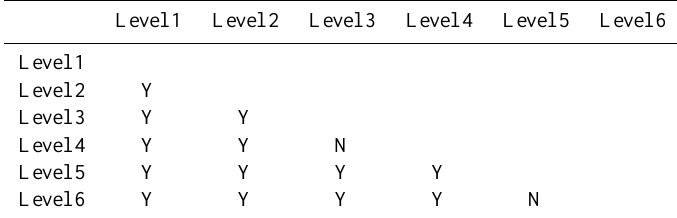
Table 4. Difference of mean improvement KRD index between levels of road